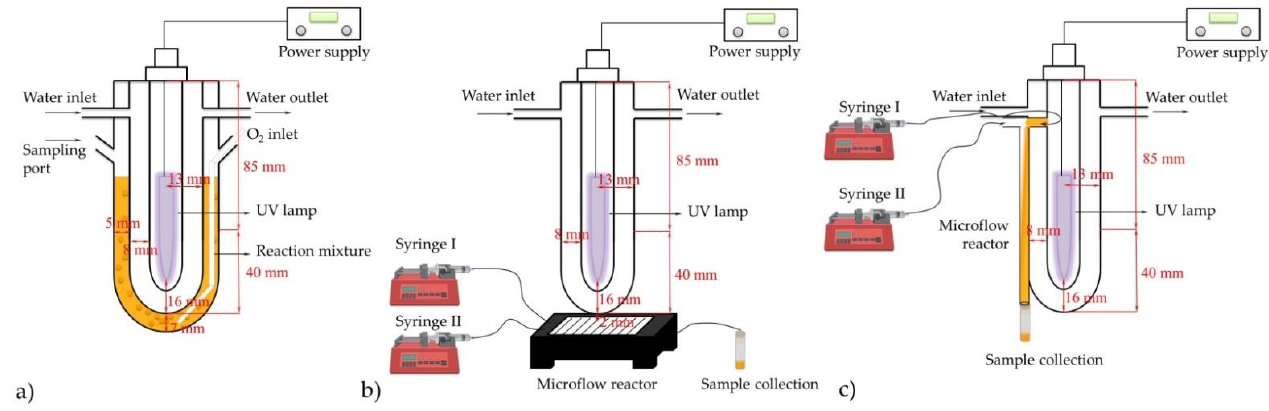
Figure 3. Experimental set-up for photocatalytic oxygenation performed in a ( a ) batch reactor, ( b ) winding geometry microflow reactor, and ( c ) straight channel microflow reactor.